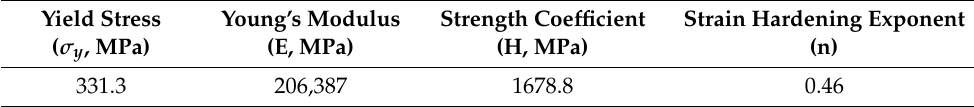
Table 2. The tensile properties of AISI 304L at room temperature